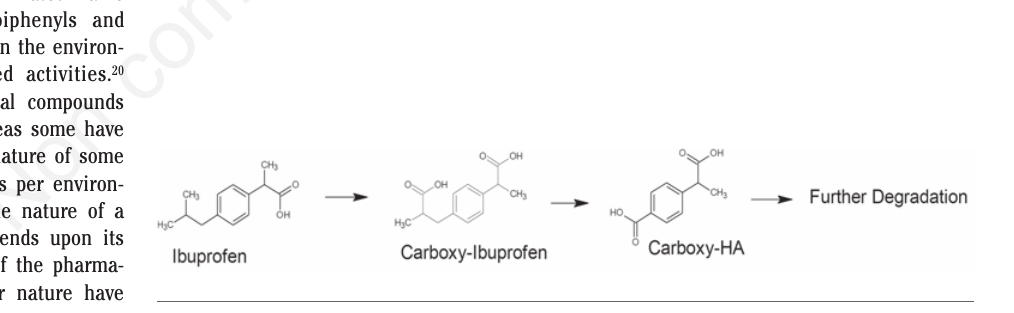
Figure 3. Oxidative metabolism of